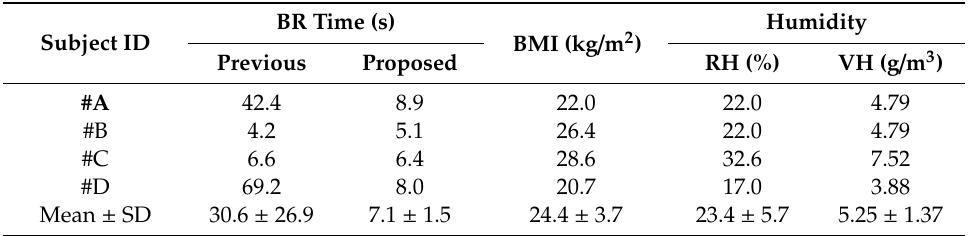
Table 4. Comparison of BR time(s) between the previous and proposed AFEs. The BMI of each subject and the humidity during each measurement are also indicated.